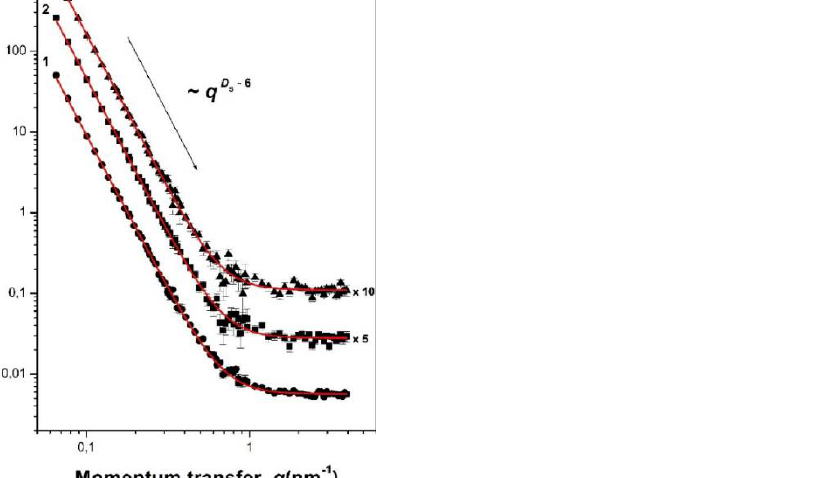
Figure 7. SANS differential cross-section d  ( q )/ d  versus momentum transfer q for the moraine samples (1 - from polygon K1; 2 and 3 - from polygon K3). Fits of experimental data using equa- tion (1) are shown as solid lines. For the sake of clarity, cross-section values for samples from poly- gon K3 were multiplied by 5 and 10 (corresponding factors are given next to the curves).